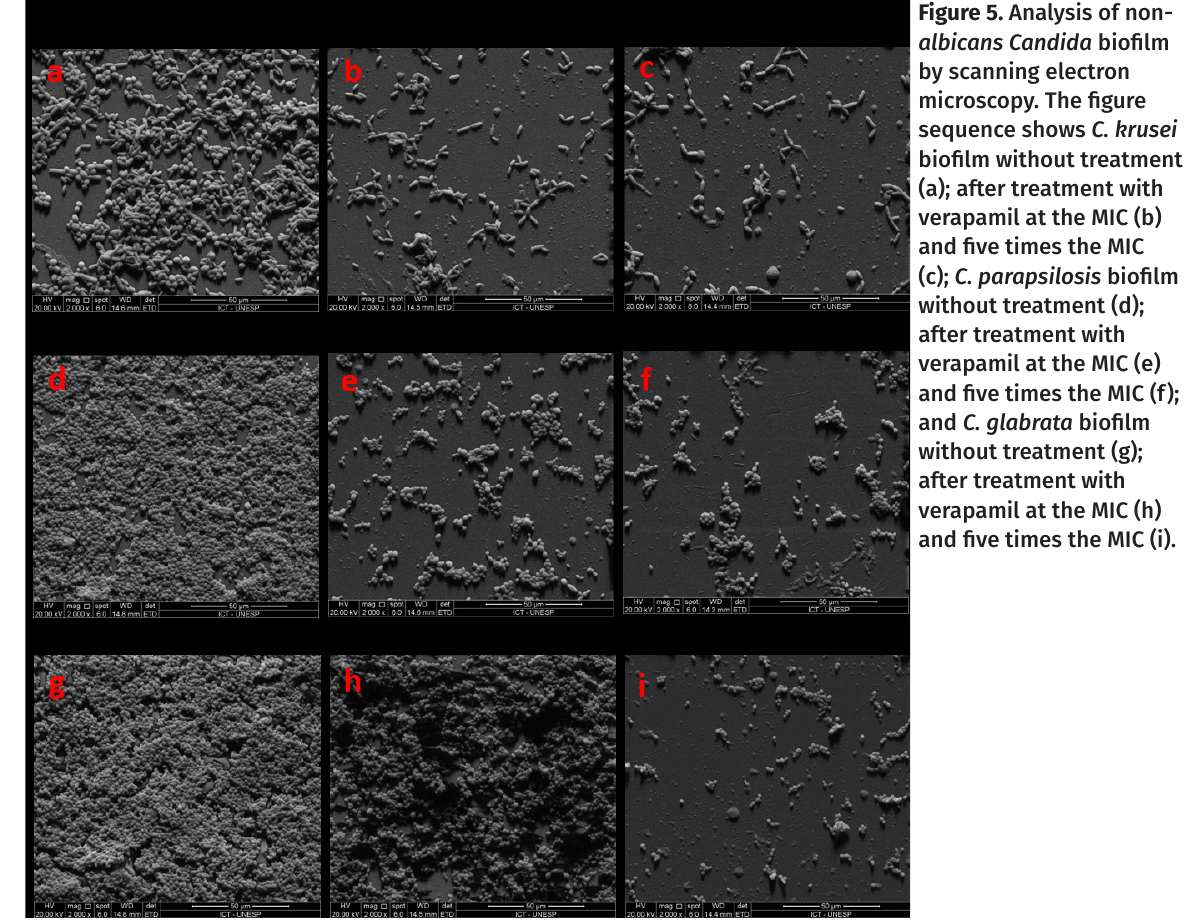
Figure 5. Analysis of non-